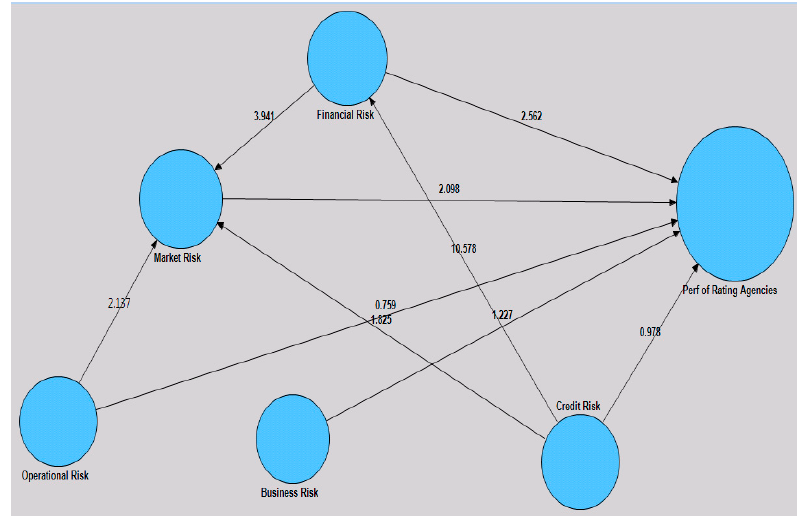
Figure 2. Results of the partial least squares (PLS) Structural Model Analysis (SmartPLS Snapshot).